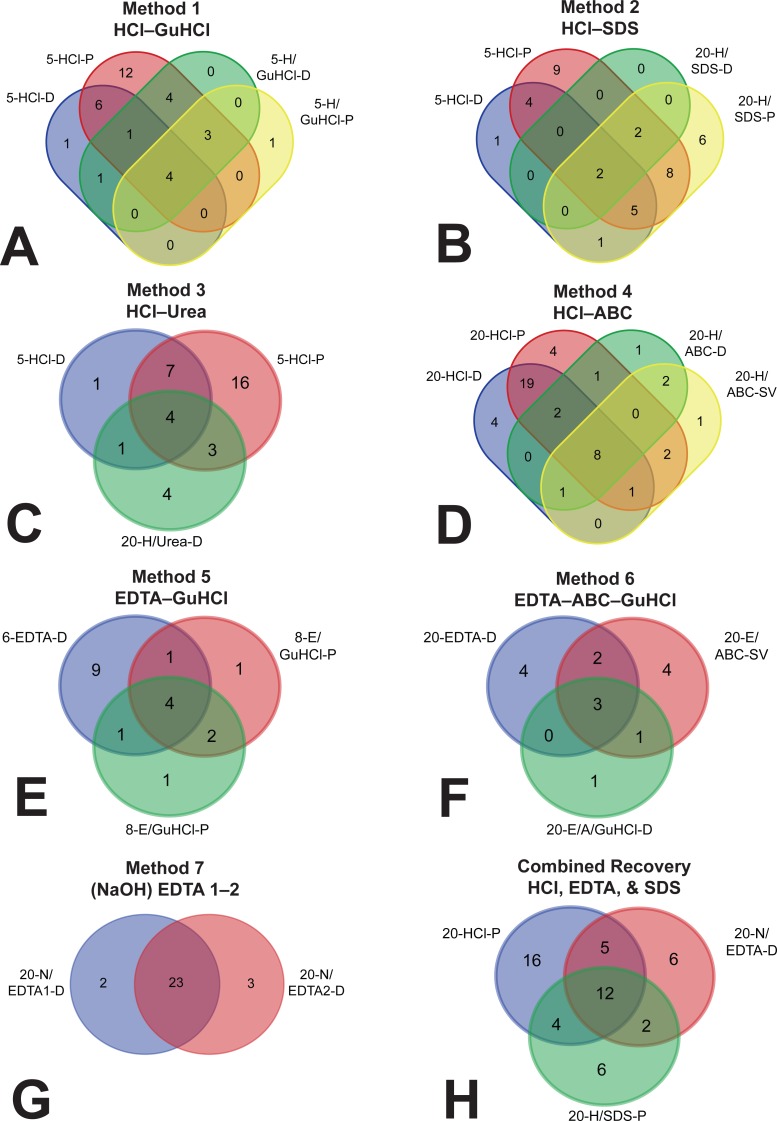
Venn diagrams depicting overlap (i.e., redundancy) of identified proteins between separate fractions.(A) Method 1, (B) Method 2, (C) Method 3, (D) Method 4, (E) Method 5, (F) Method 6, (G) demineralization fractions of Method 7, and (H) a hypothetical method that combines three fractions to maximize recovery. In methods 1–5 (A–E), there was a large amount of overlap between the demineralization and solubilization fractions, and most of the unique proteins were found in the demineralization fractions,rendering the solubilization fractions largely redundant. In Method 6 (F), there were slightly more unique proteins in the two solubilization fractions (combined) than in the one demineralization fraction. In Method 7, there was substantial redundancy in the two sequential demineralization incubations, indicating that additional demineralization did not recover substantially new portions of the proteome. Combining three fractions (i.e., 20-HCl-P, 20-N/EDTA-D, and 20-H/SDS-P) into a hypothetical extraction (H) accounted for 51 of the 55 proteins identified across all fractions in this study, with the largest contribution of unique proteins coming from HCl.